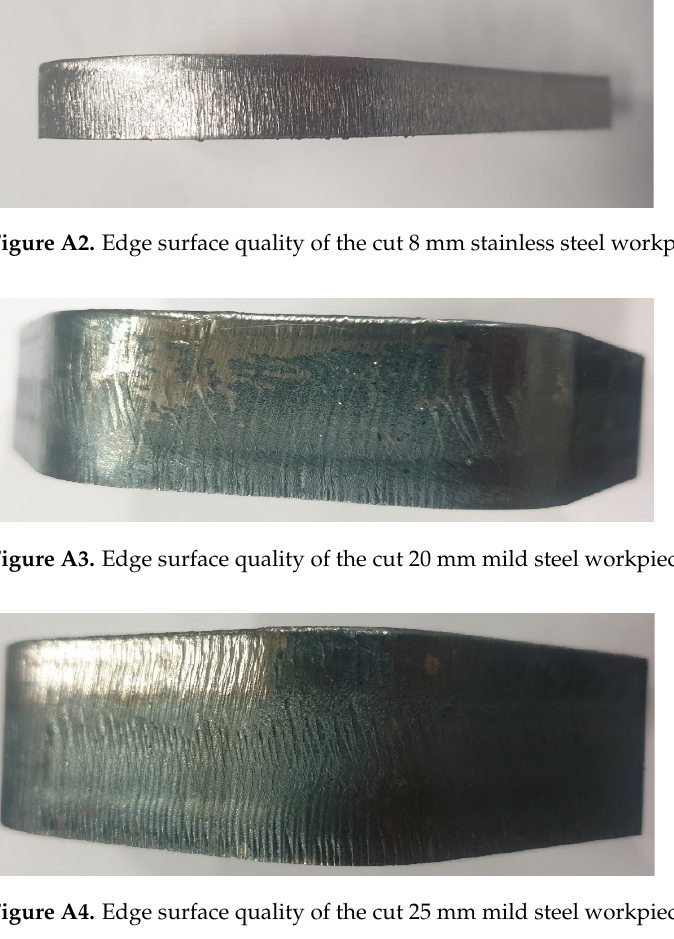
Figure A1. Edge surface quality of the cut 8 mm aluminum workpiece.